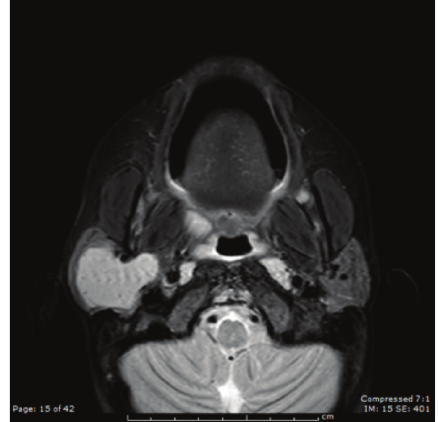
Figure 2: Axial T2 weight MRI shows a hyperintense